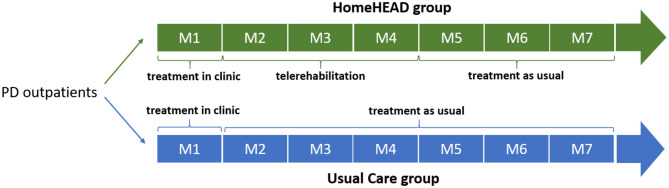
Timeline of the HEAD trial.